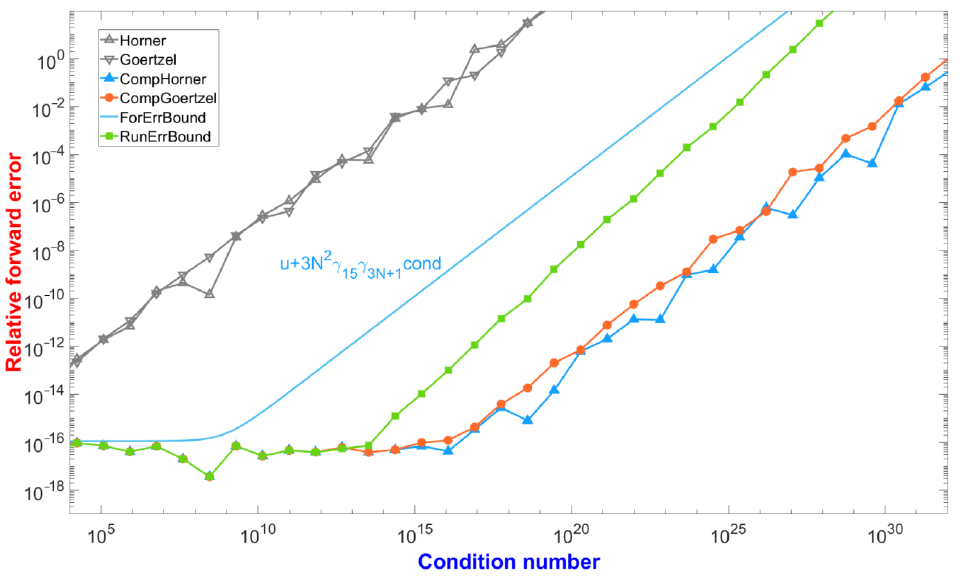
Figure 3. Accuracy of evaluation of ω ( z ) = ( z − 1 − i ) n at z = 1.333 + 1.333 i for n =